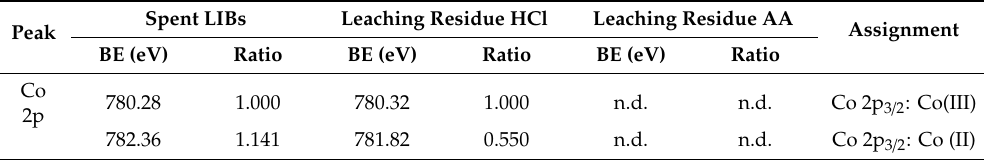
Table 2. XPS analysis of surface compositions of spent LIBs’ powder and leaching